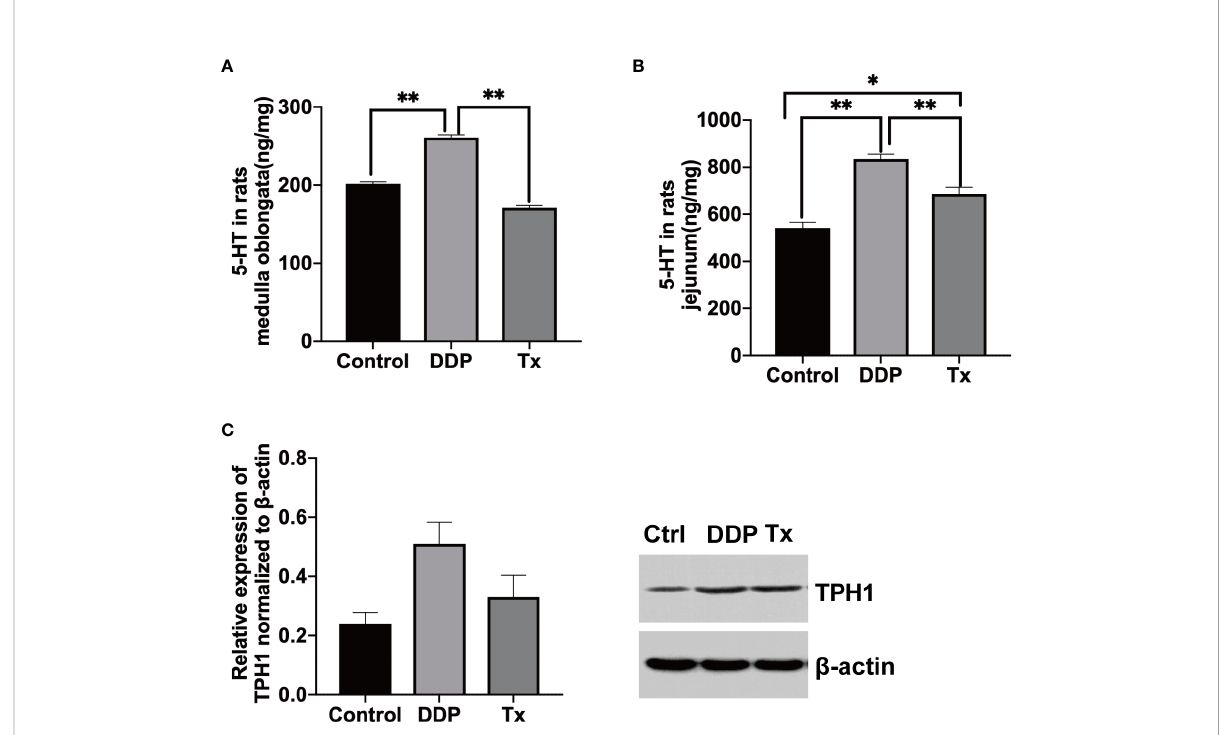
FIGURE 3 LJAW Downregulated the Secretion of 5-HT in Both the Jejunum and Medulla Oblongata by Inhibiting THP1 in Rats. (A) 5-HT concentration in rat jejunum tissue(n = 5, data are presented as mean ± sem, normality was tested by Shapiro-Wilk normality test, p values were determined by using one-way ANOVA, *, p < 0.05, **, p < 0.01). (B) 5-HT concentration in rat medulla oblongata tissue(n=5, data are presented as mean ± sem, normality was tested by Shapiro-Wilk normality test, p values were determined by using one-way ANOVA, *, p < 0.05, **, p < 0.01). (C) Expression of TPH1 in rat jejunum tissue(n=3, data are presented as median with interquartile range, normality was tested by Shapiro-Wilk normality test, p values were determined by using one-way ANOVA, *, p < 0.05, **, p <